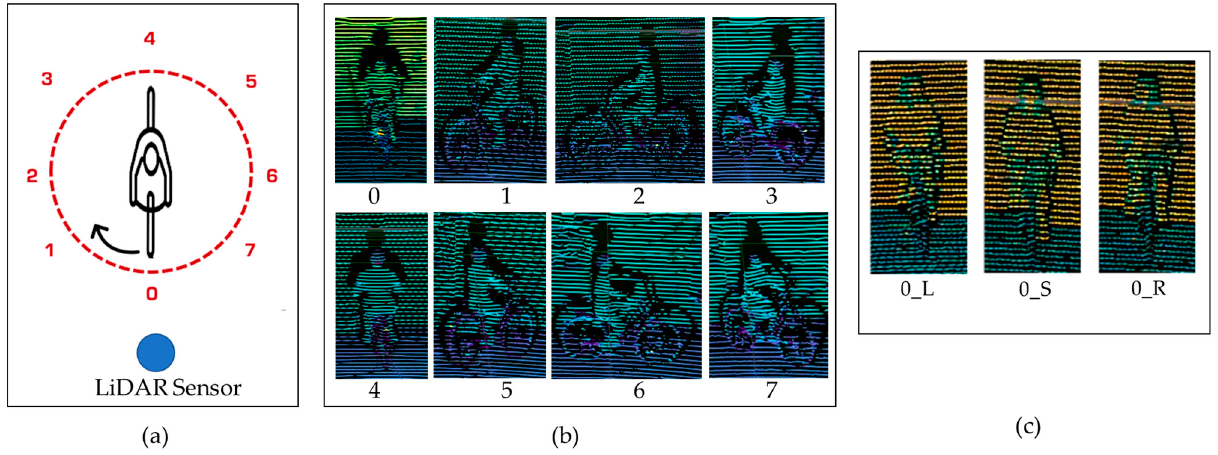
Figure 1. Demonstration of the definition of body orientation ( a , b ) and head orientation ( c ).